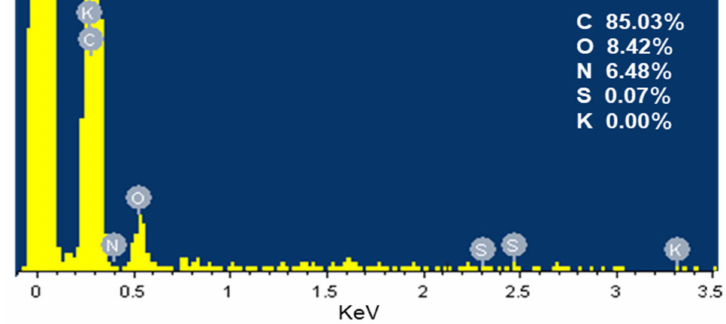
Figure 2. EDS spectrum of